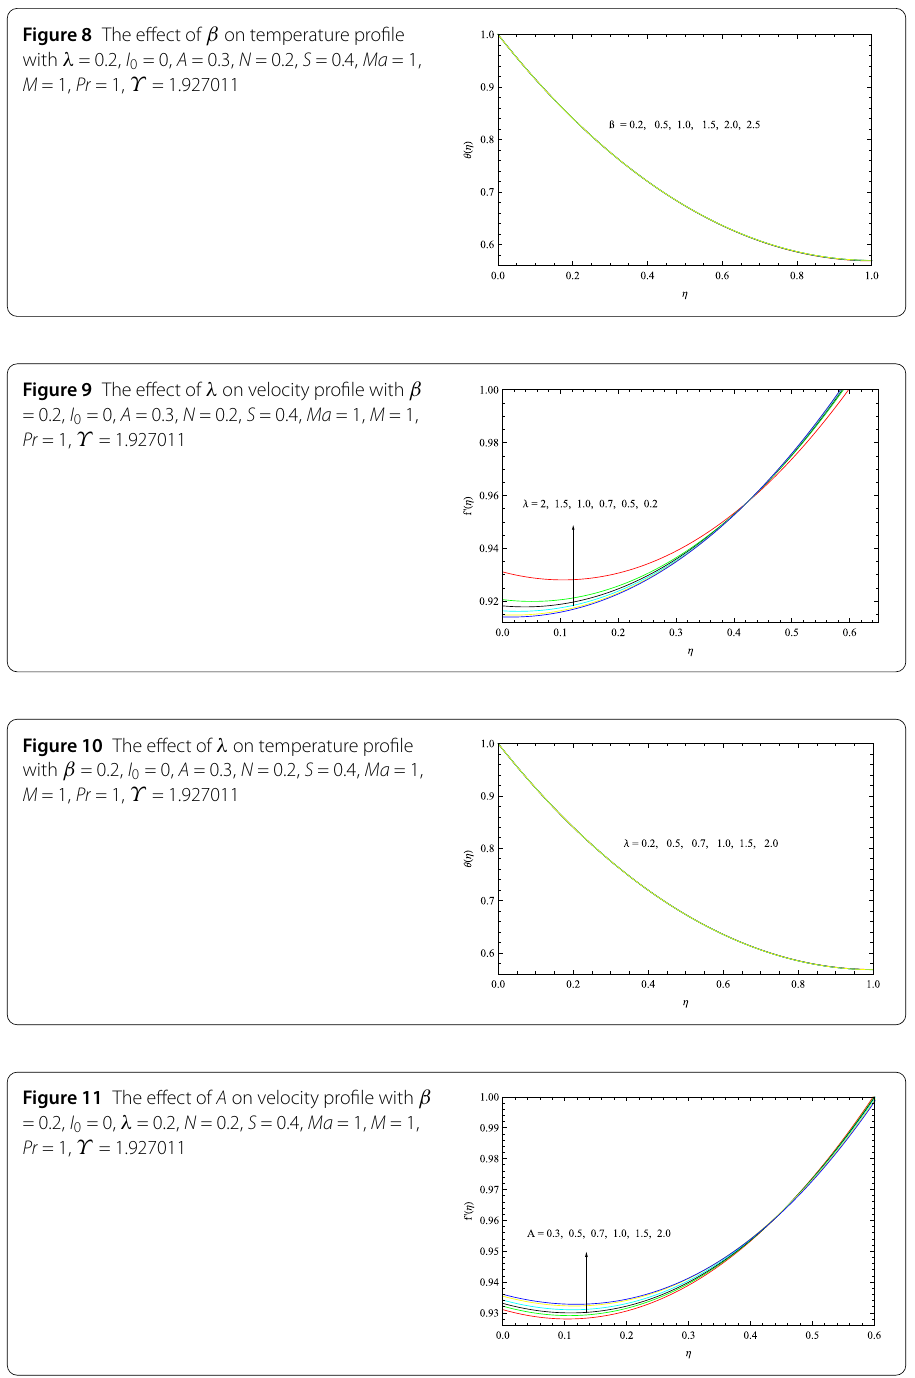
Figure 8 The effect of β on temperature profile